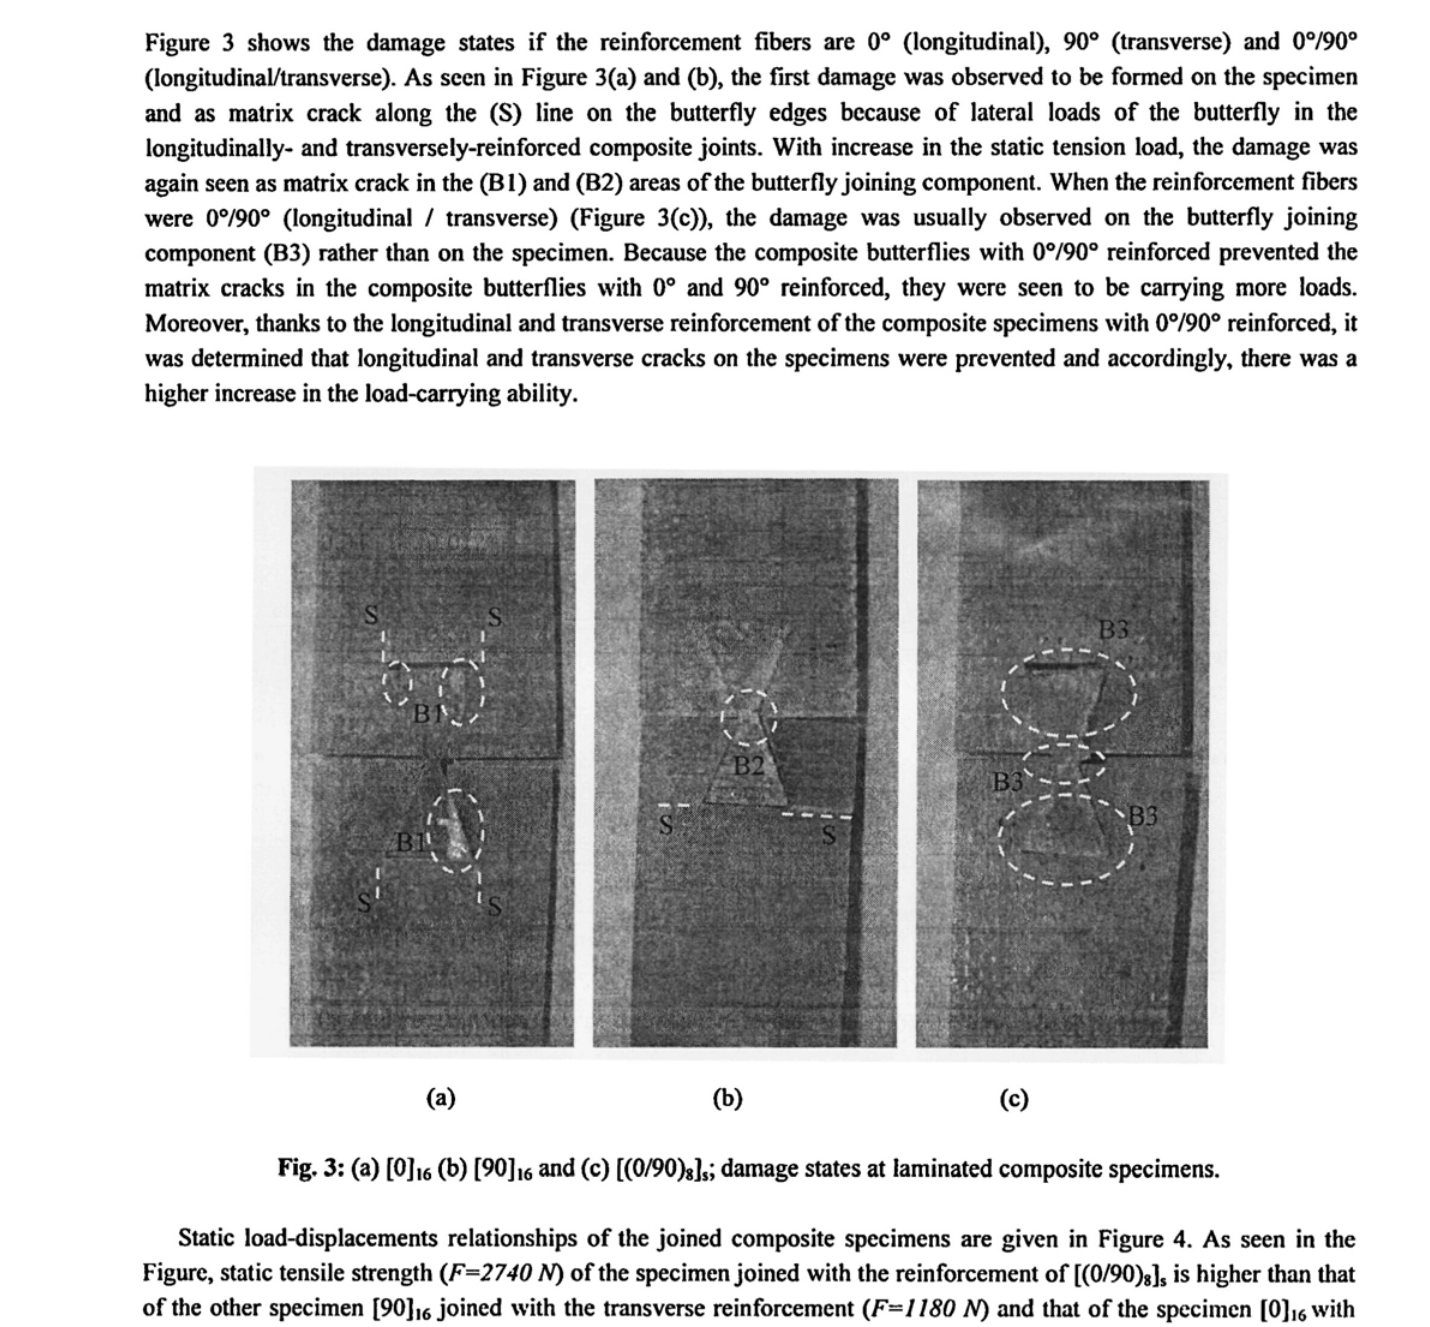
(b) [90]i and (c) [(0/90) !6 6